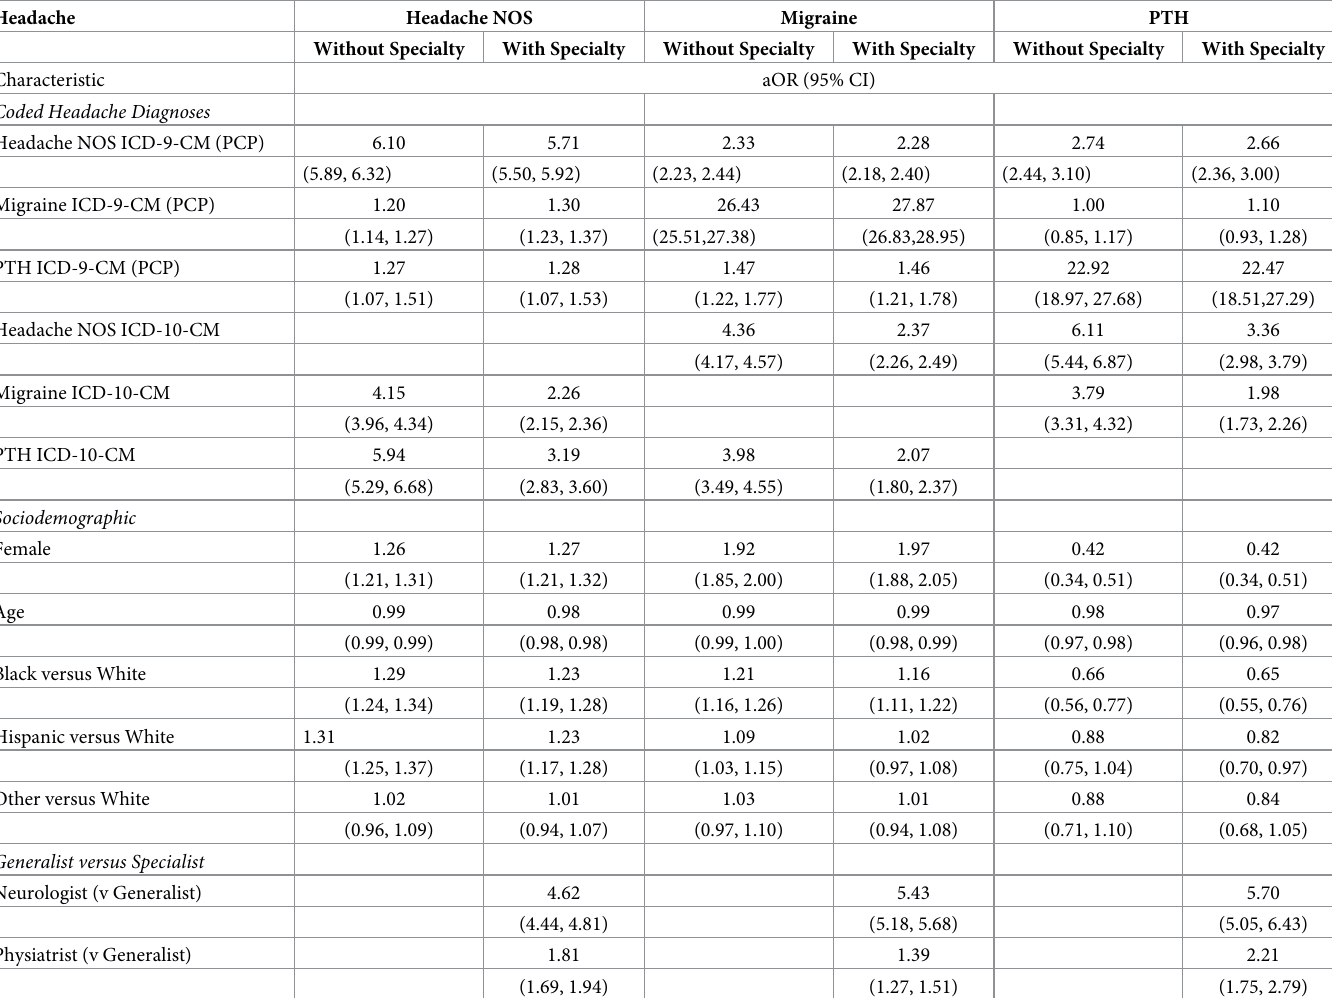
Table 3. Probability modeled is ICD-10-CM headache NOS, migraine, and post-traumatic headache, with and without modeling